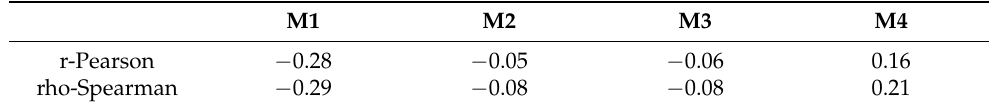
Table 2. Values of the correlation coefficient between the hourly volumes of electricity consumption and horizontal insolation per year (8760 h) in 4 analyzed cases of mines.